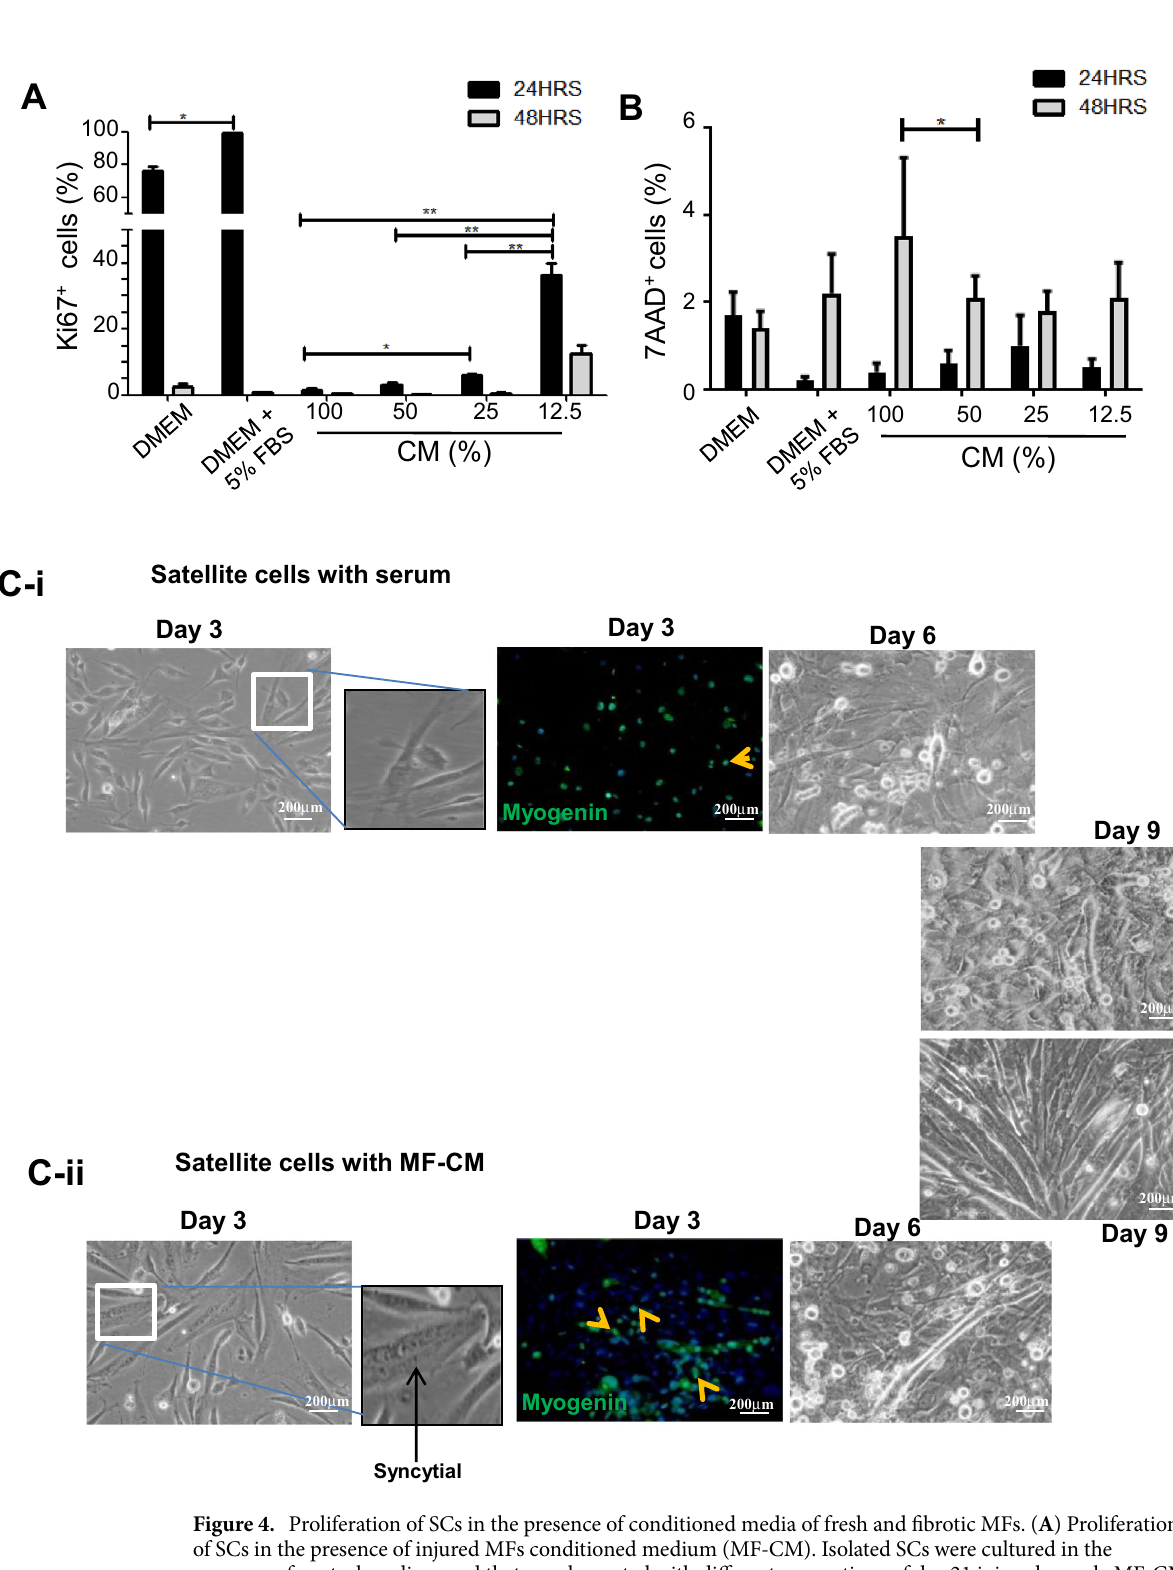
Figure 4. Proliferation of SCs in the presence of conditioned media of fresh and fibrotic MFs. ( A ) Proliferation of SCs in the presence of injured MFs conditioned medium (MF-CM). Isolated SCs were cultured in the presence of control medium and that supplemented with different proportions of day 21 injured muscle MF-CM for 24 and 48 h. Readout of the assay was based on Ki-67 staining of the cells. ( B ) 7AAD staining (indicative of dead cells). ( C-i ) and ( C-ii ) SCs of healthy mice were cultured in the presence of 5% serum supplemented ( top panel ) and 50% CM of freshly isolated MFs ( bottom panel ) for 9 days. Syncytial cells were stained with myogenin (indicated with yellow arrows) and documented in bright field images. Data were presented as mean ± SEM. **p < 0.01, *p <